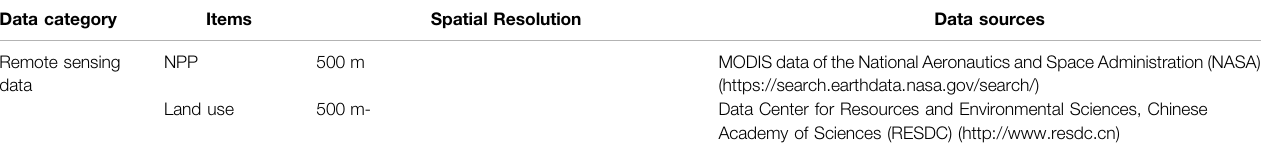
TABLE 1 | Data type and sources.